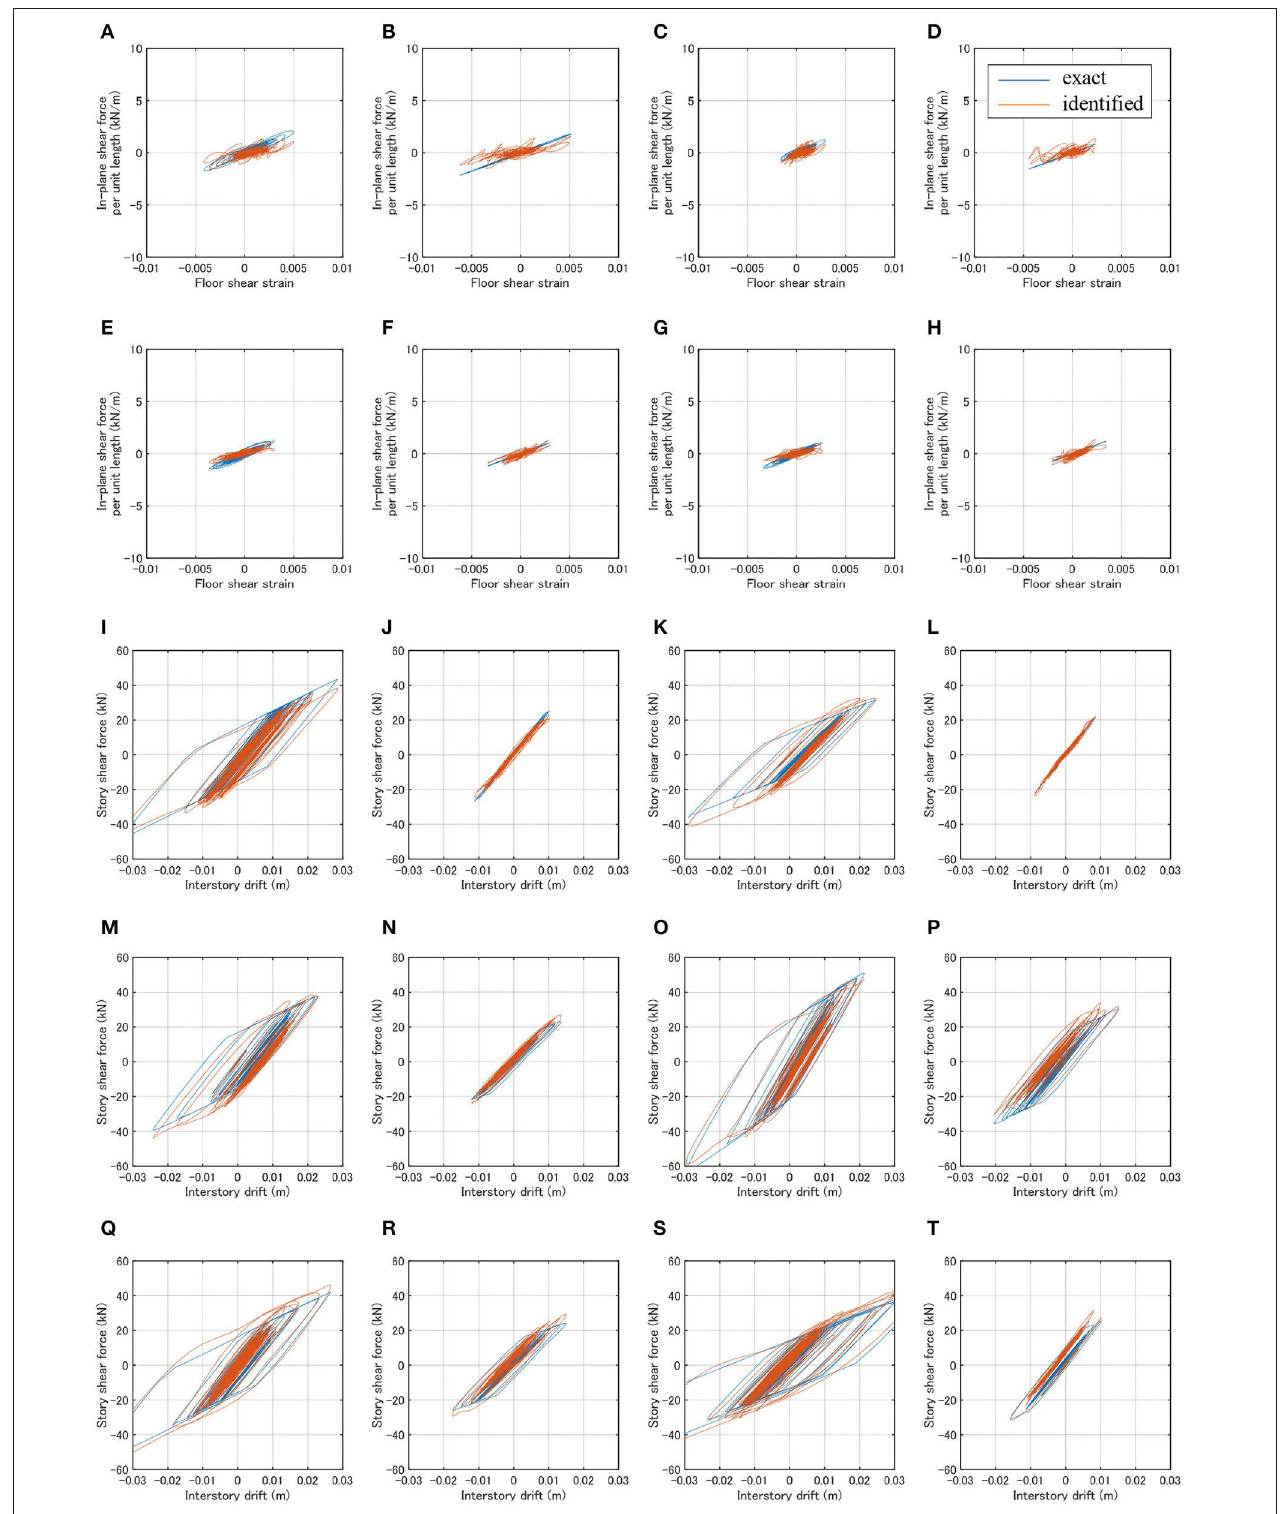
FIGURE 7 | Identification results (El Centro 1940 NS). (A) H-frame (x1y1_1F). (B) H-frame (x1y2_1F). (C) H-frame (x2y1_1F). (D) H-frame (x2y2_1F). (E) H-frame (x1y1_2F). (F) H-frame (x1y2_2F). (G) H-frame (x2y1_2F). (H) H-frame (x2y2_2F). (I) V-frame (x1_1F). (J) V-frame (x1_2F). (K) V-frame (x2_1F). (L) V-frame (x2_2F). (M) V-frame (x3_1F). (N) V-frame (x3_2F). (O) V-frame (y1_1F). (P) V-frame (y1_2F). (Q) V-frame (y2_1F). (R) V-frame (y2_2F). (S) V-frame (y3_1F). (T) V-frame (y3_2F).